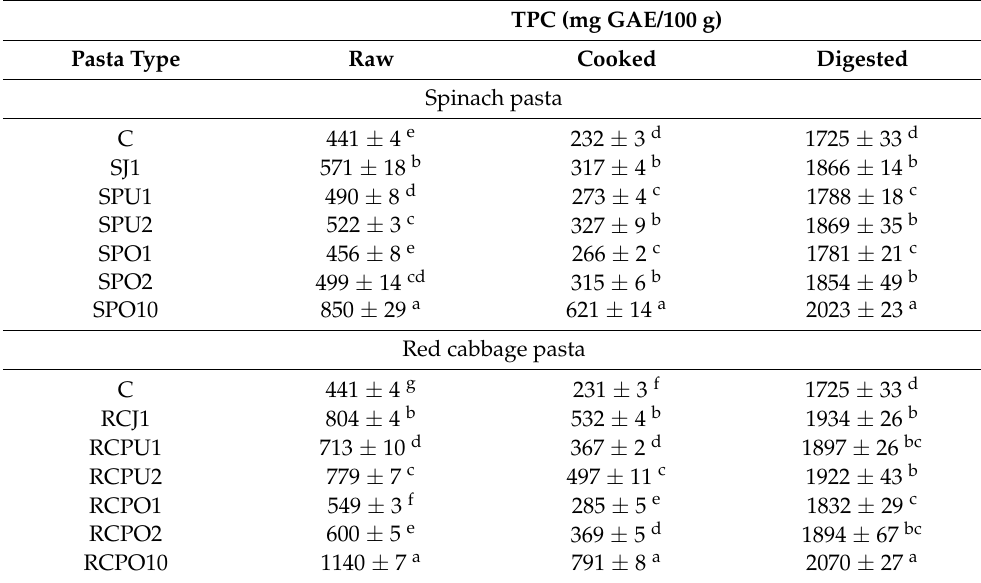
Table 4. Total Phenolic content and antioxidant capacity of spinach and red cabbage